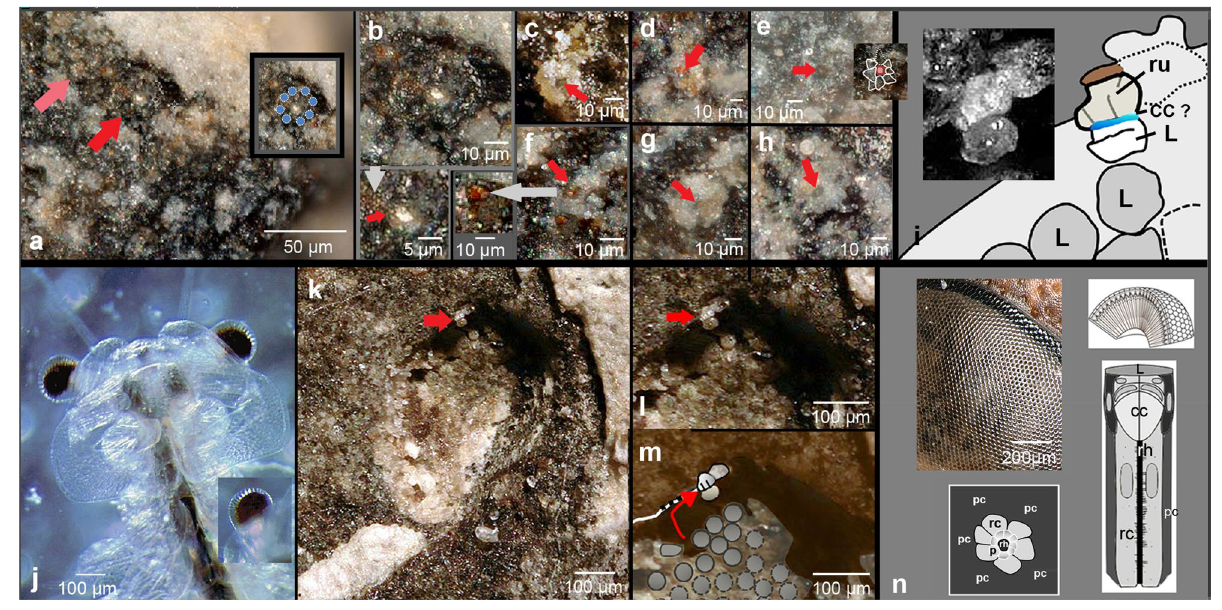
Figure 2. Ommatidial structures and their interpretations. ( a ) Overview of another sensory unit, fossilised in a different way (red arrow); another, slightly weathered adjacent (pink arrow). Insert: Position of the relics of receptor cells marked. ( b ) (a) in detail. Note the rhabdom embraced by spherical elements, interpreted as putative ‘palisades’ 63–65 . ( c–h ) More examples of receptor-cell-rosettes with rhabdoms (red arrows) surrounded by palisades, f repeats the spherical elements very clearly. ( i ) Schematic drawing of (Fig. 1k), the putative thin crystalline cone in blue. ( j ) Translucent head of Artemia salina (Linnaeus, 1758), showing up the screening pigments inside of the compound eye. ( k ) Overview of the counterpart of the eye, red arrow indicates the position of the individual visual unit of Figs. 1k, 2i. ( l,m ) Illustration of how the isolated visual unit may have come up to its position, being stripped of the layer of lenses seen at their proximate surface below. ( n ) Modern compound eye of a hornet ( Vespa crabro Linnaeus , 1758) and schematic drawing of an apposition compound eye, ommatidium and its cross-section. c cavity, formerly containing the receptor unit, cc crystalline cone, p palisade, pc pigment cells, rc receptor cell, rh rhabdom, ru receptor unit, L lens; o–q, s from the right